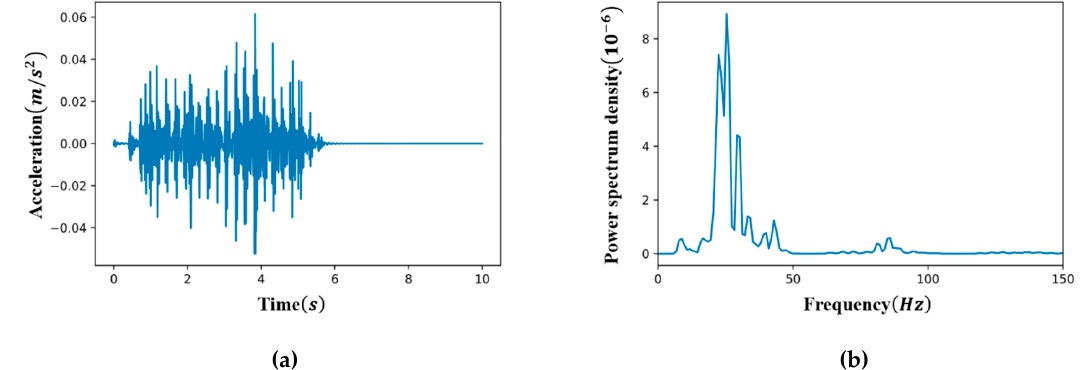
Figure 5. Example of an acceleration data from measurement point 3 when a car passes through lane 1 at 20 km/h (sampling rate = 1,000 Hz) and a power spectral density of acceleration. (a) Acceleration data; (b) Power spectral density of the acceleration.